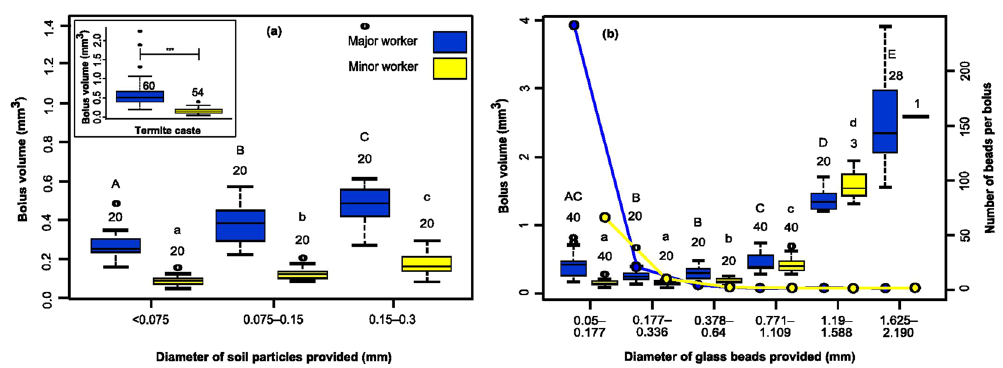
Figure 2. Boluses made with different materials. ( a ) Boluses made with soil of different particle sizes; inset shows boluses made in situ at 5 termite mounds; ( b ) Boluses made with glass beads of different sizes; dots represent number of beads per bolus; box plots with horizontal lines indicating median, bottom and top of the box indicating 25th and 75th percentiles respectively, and whiskers indicating either the maximum value or 1.5 times the inter-quartile range, whichever is smaller. Numbers above box plots indicate sample sizes. Capital and small alphabets indicate within-caste significant differences obtained from Tukey’s HSD tests for major and minor workers